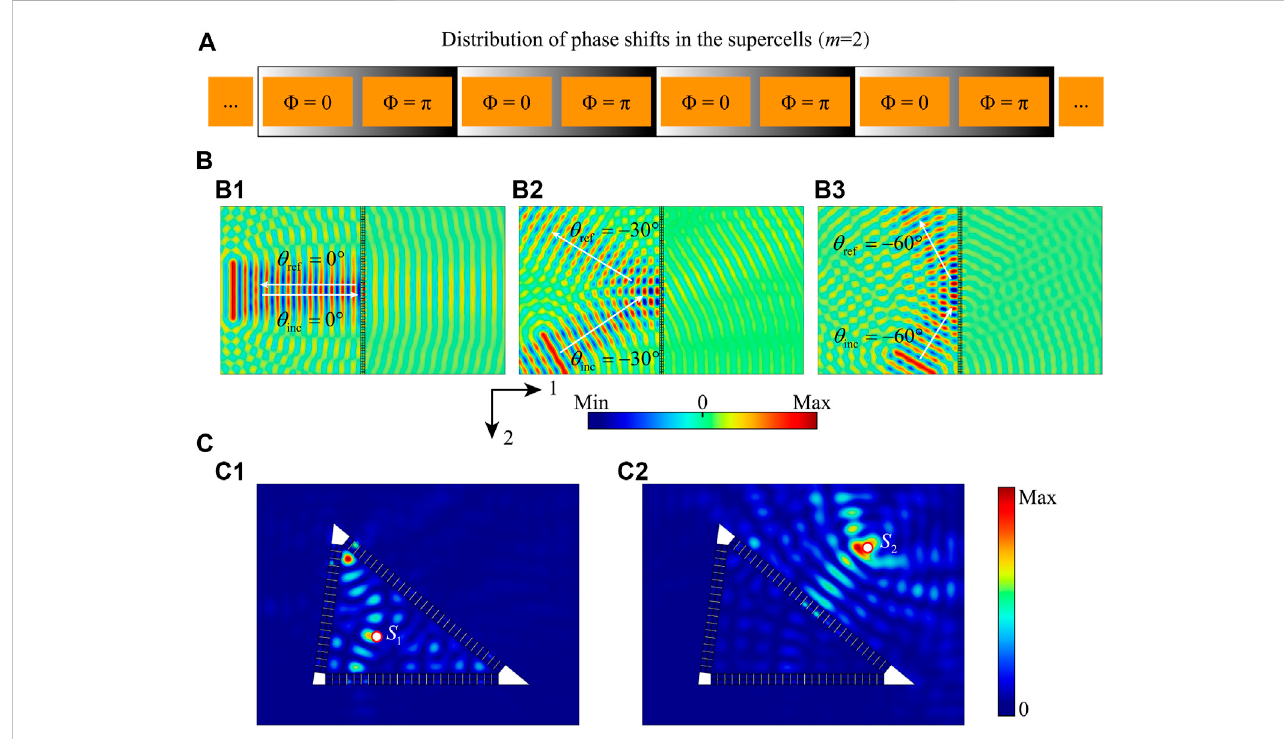
FIGURE 6 (A) Distribution of phase shifts along the supercell with m = 2. (B) Out-of-plane displacement fi elds of 0 ° , − 30 ° , and − 60 ° incident angles. (C) Energy fi eld when a point source is placed inside and outside the triangle-shaped